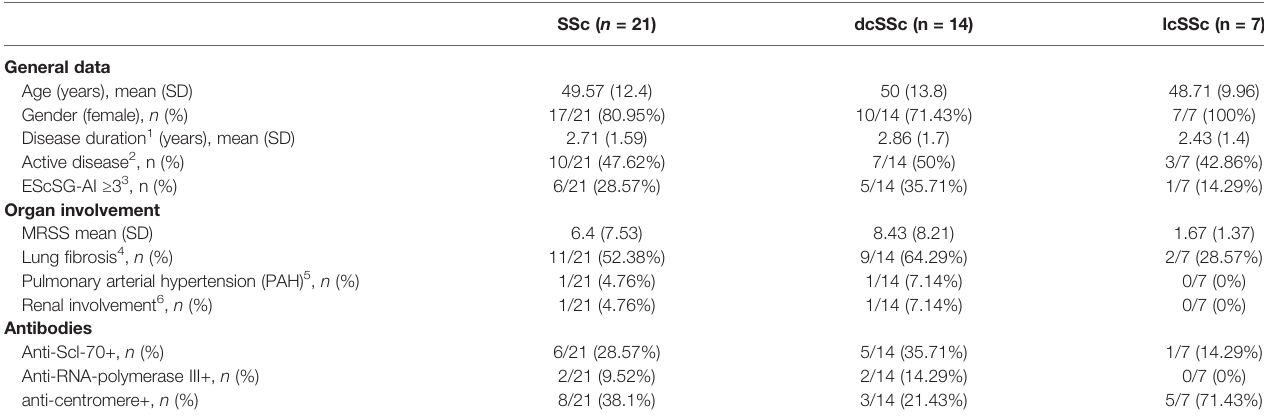
TABLE 1 | Patients ’